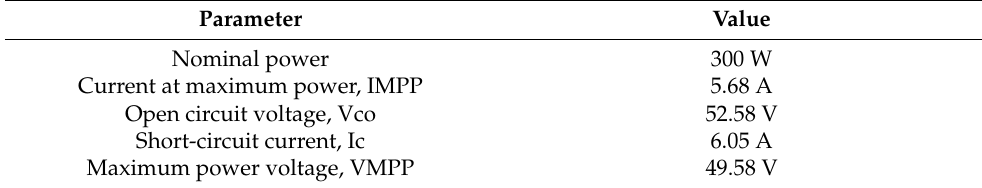
Table 2. Features of (Sun Power SPR-300NE-WHT-D) PV model.